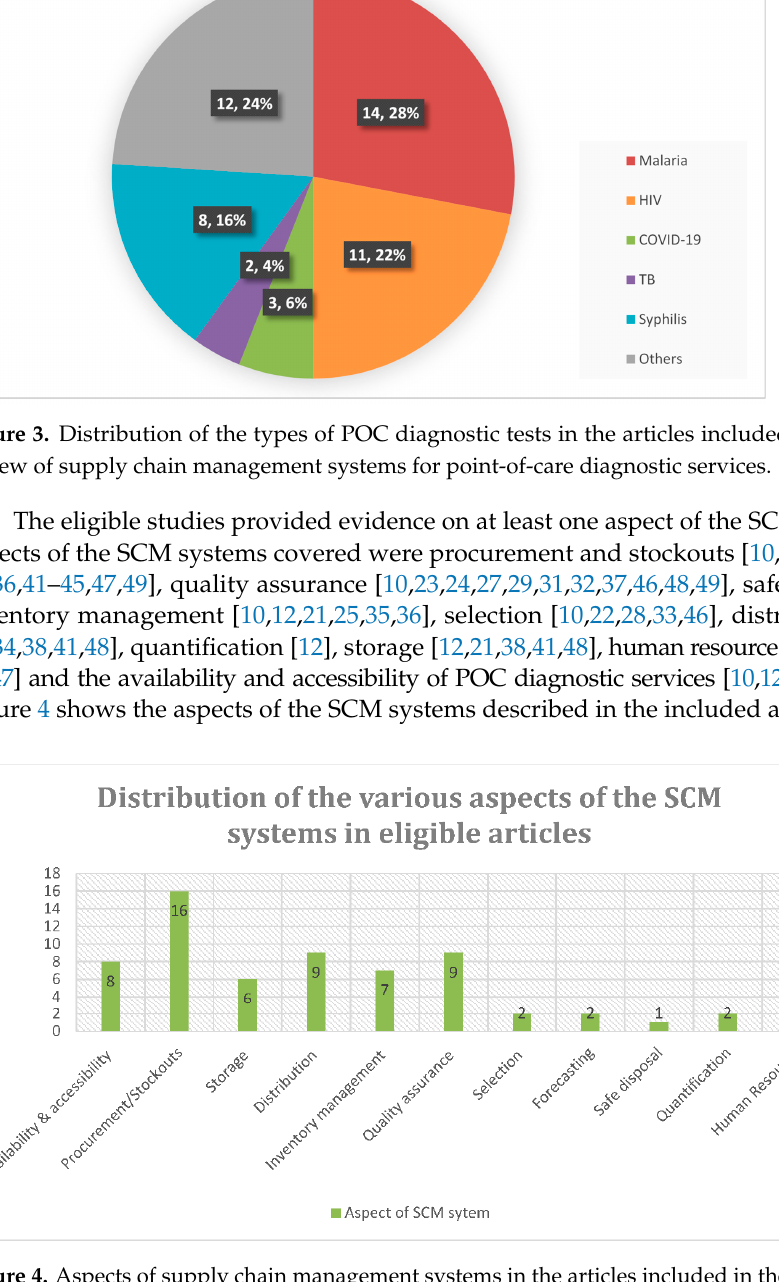
Figure 4. Aspects of supply chain management systems in the articles included in the scoping review on supply chain management systems for point-of-care diagnostic services.